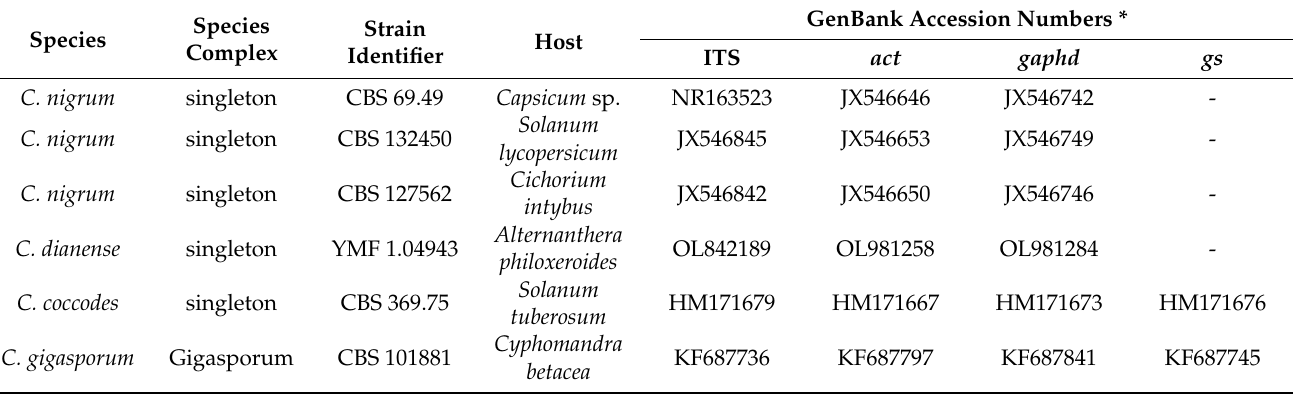
Table 2. Reference strains used in this